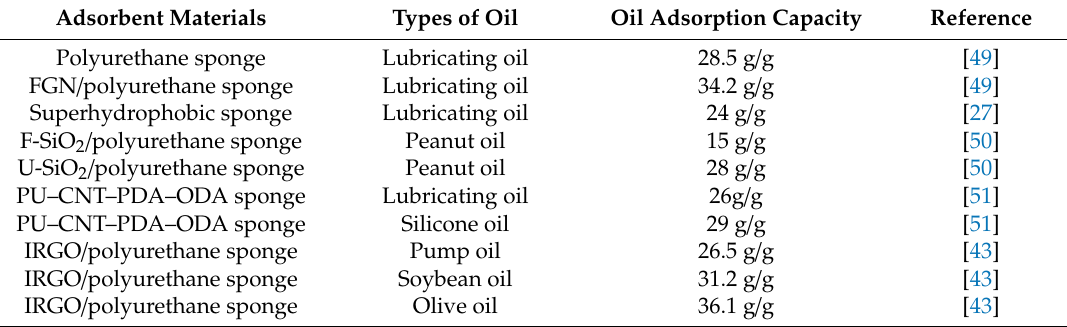
Table 2. Oil adsorption capacity of di ff erent adsorbent materials.